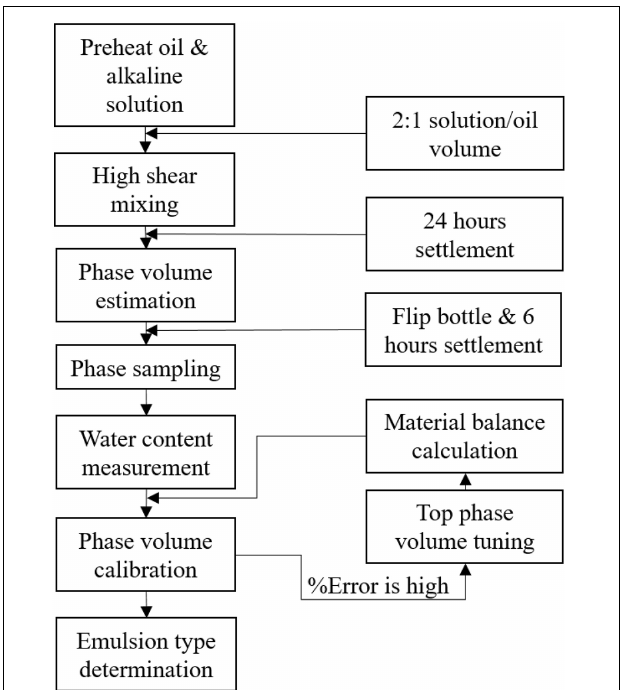
FIGURE 3 | Workflow of modified bottle